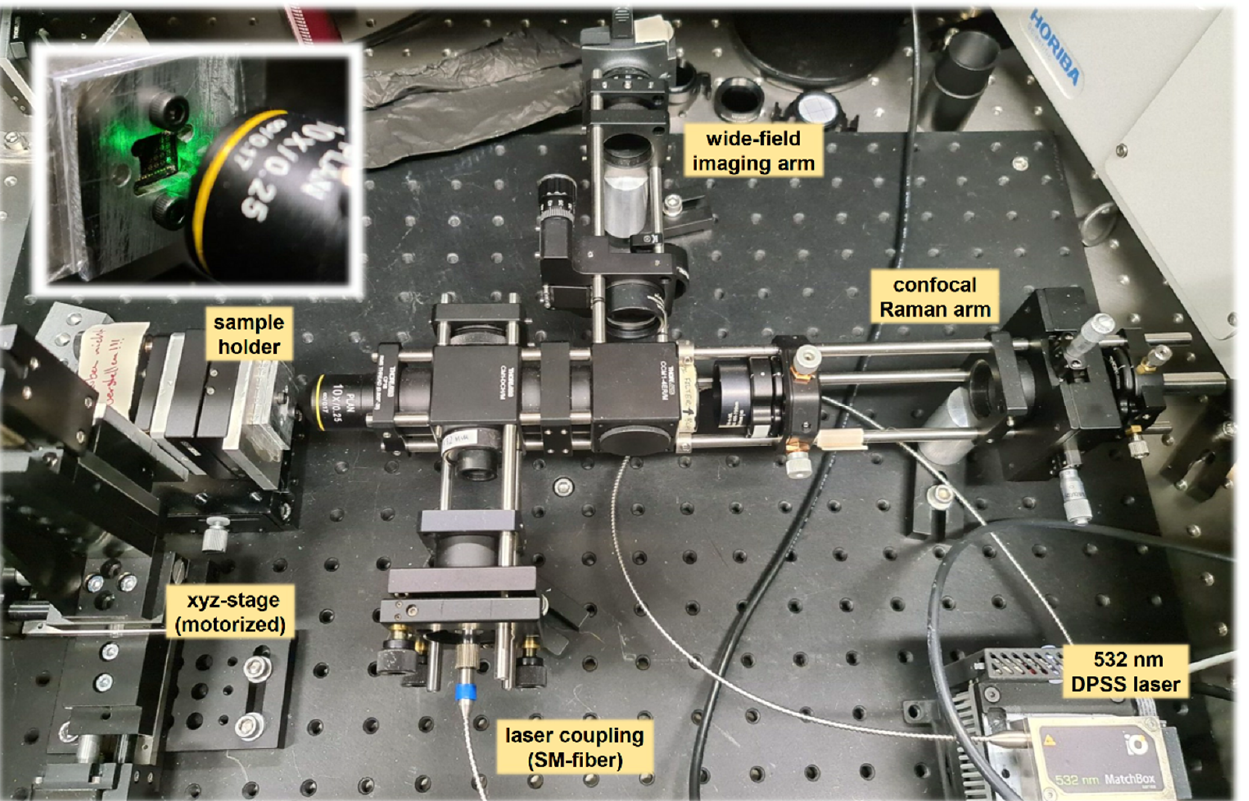
Figure 2. Overview image of the confocal Raman microscope system, as shown schematically in Figure 1, together with the xyz-motorized sample stage and the (fiber-coupled) excitation laser. Insert: a GFET sample mounted on the xyz-stage, illuminated by laser light through the CRM objective. Key structural elements in the image are annotated; breadboard tapped-hole spacing = 25 mm.